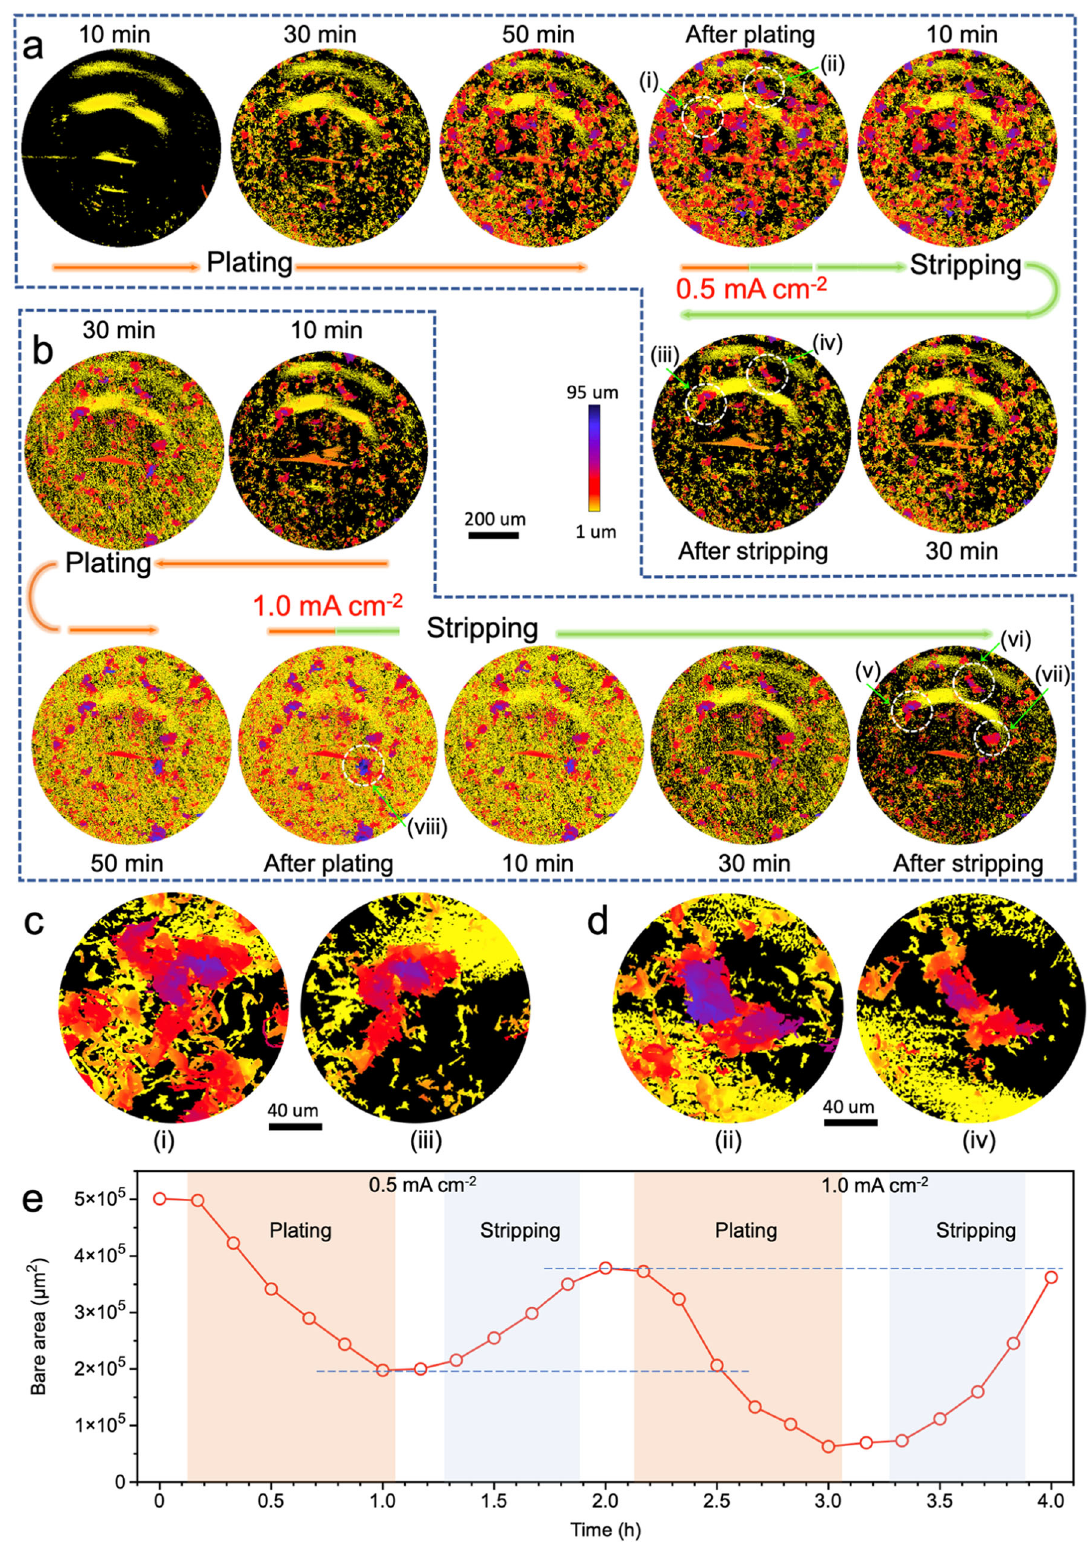
Fig.5|HeightmapsofdepositedLiatdifferentstagesofplatingandstripping. a , b Height maps of Li deposited at 0.5mAcm – 2 in the fi rst cycle ( a ) and at 1.0mAcm − 2 inthe second cycle ( b ), respectively.Theheightof Liprojected onone pixel (0.325 μ m×0.325 μ m) on the Cu surface is visualized by the color scale bar. The black pixels are bare Cu substrate. Typical Li microstructures identi fi ed as electrochemically inactive are marked by white dashed circles and labeled from (i)